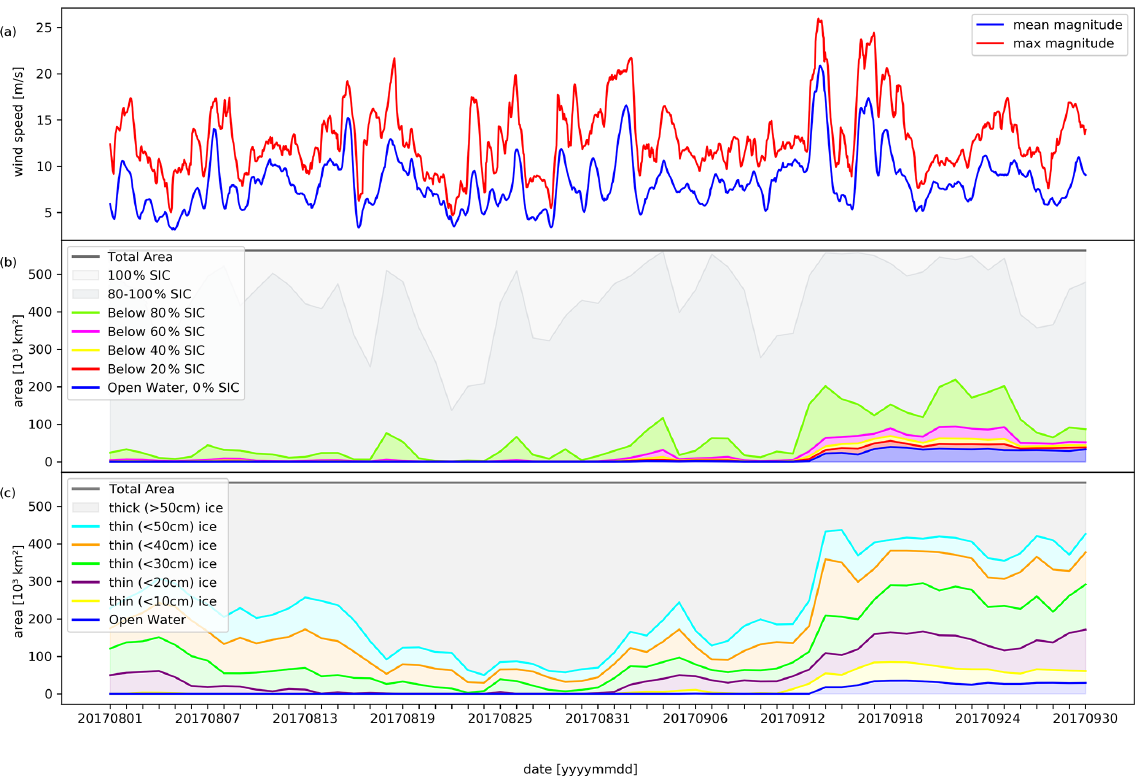
Figure 5. August–September 2017: (a) daily ERA5 wind speed at 1000hPa (red: daily maximum; blue: mean computed for the region outlined by the bounding box in Fig. 1). (b) ASI SIC where each line represents ice that falls below a SIC value shown in the legend. Each filled-in area represents sea ice within the range set by the lines such that all the colors match the color of the lines that are directly above them (e.g., the green shading below the green line represents 60%–80% SIC area). The uppermost grey line represents the total area (562.5 × 10 3 km), and the variation in shading below it is as follows: light grey is for the whole area that is 100% SIC, and the darker grey is reserved for everything that falls between 80% and 100% SIC. (c) SMOS–SMAP ASIT where each line represents sea ice below a thickness shown in the legend. Each filled-in area represents sea ice within the range set by the lines such that all the colors match the color of the lines that are directly above them (e.g., the cyan shading below the cyan line represents the 40–50cm ASIT area). The grey line represents the total area (562.5 × 10 3 km) like in the SIC plot, and the grey shading represents sea ice that is identified to be > 50cm. All plots cover the area of interest outlined in Fig.